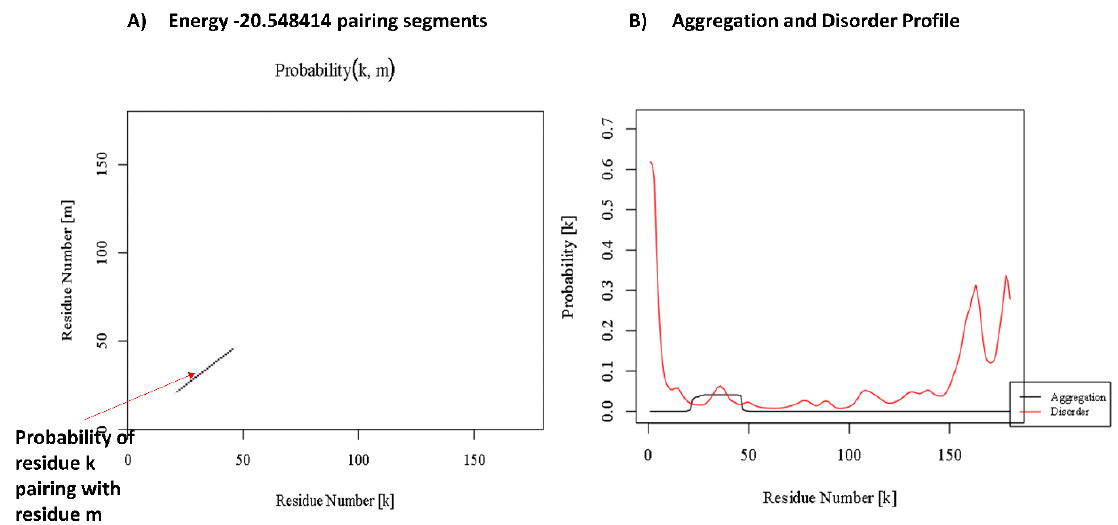
Figure 8. ( A ) Pairing results in PASTA2.0 for tetherin. ( B ) Aggregation and disorder profile of tetherin-derived in PASTA2.0 .